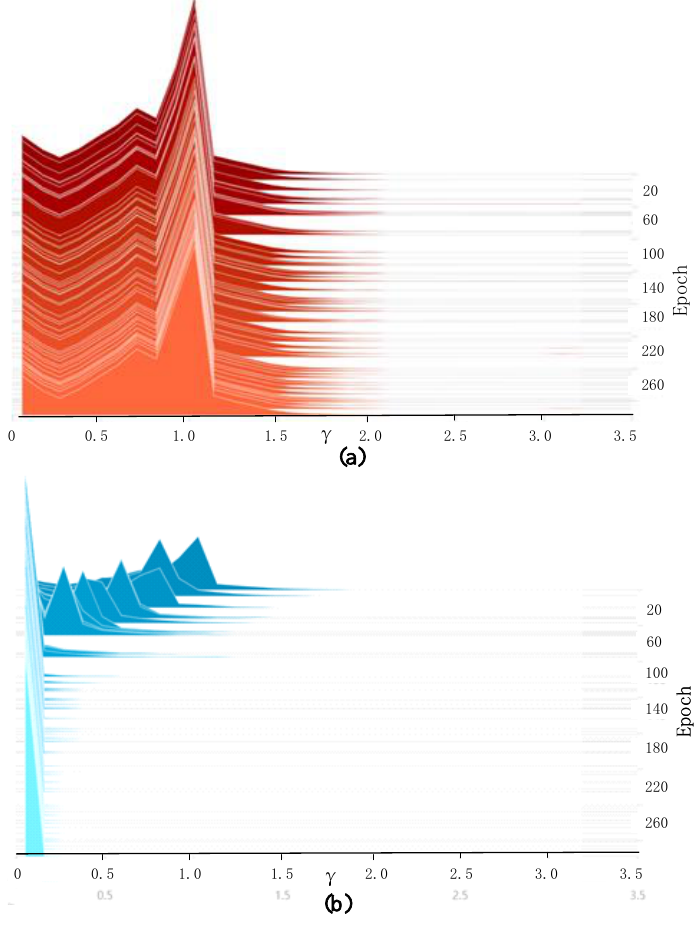
Figure 5. Distribution of γ factor in the BN layer: ( a ) routine training and ( b ) sparse